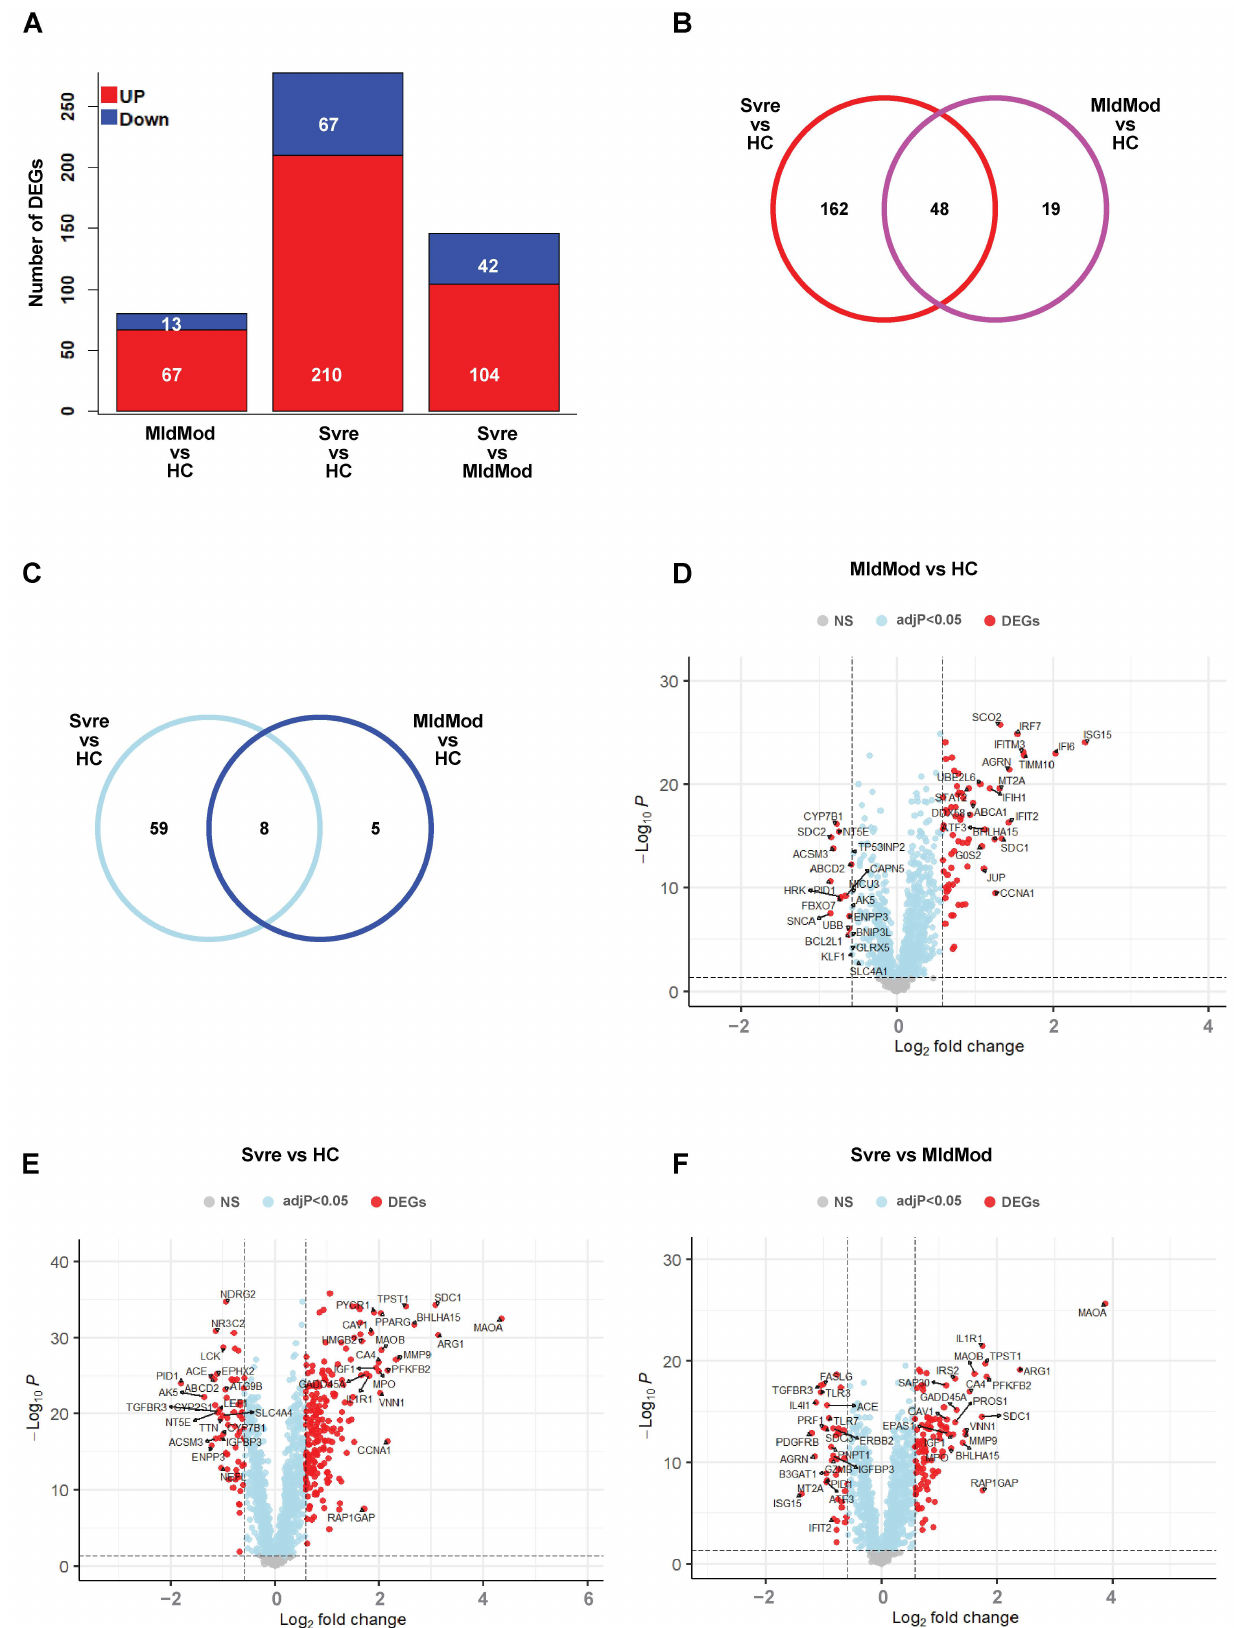
Figure 2. DEGs from comparisons of severity groups. ( A ) Bar diagram showing the number of up- (in blue) and downregulated (in red) DEGs from three comparisons: mild/moderate versus